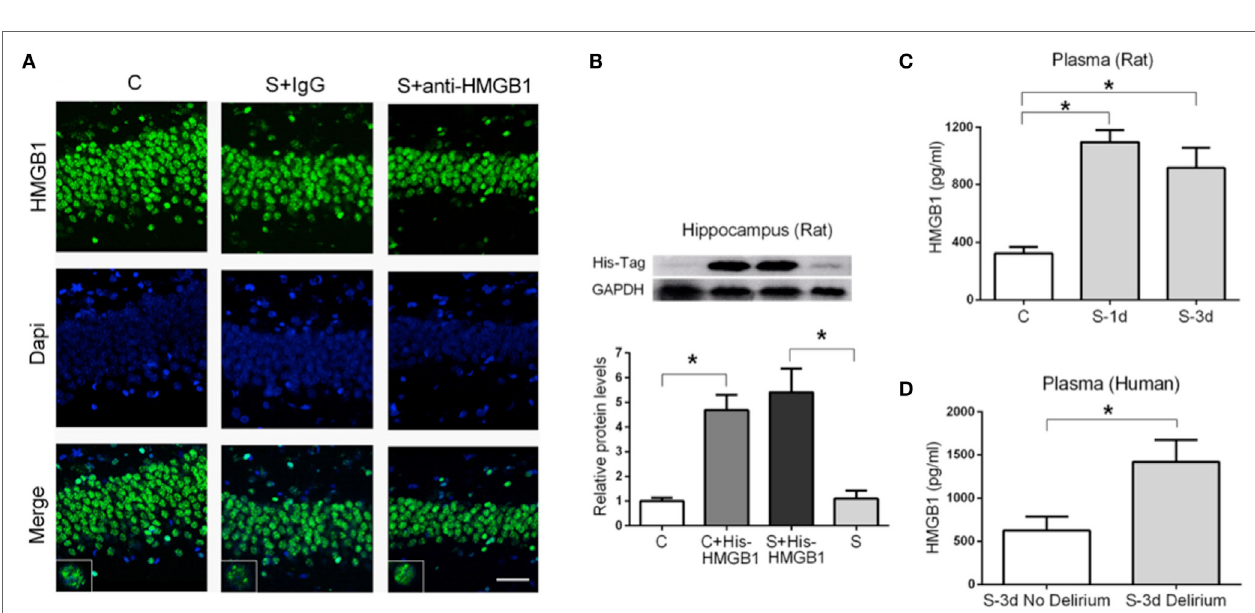
FigUre 4 | Microglia activation after surgery and effects of anti-hMgB1 . Neuroinflammation was assessed by Iba-1 immunofluorescence on postoperative day 3. Photomicrographs from DG and CA1 areas of the hippocampus are shown (a) . Surgery activated microglia as noted by morphological changes on day 3, including enlargement of cell bodies, which was attenuated by anti-HMGB1 mAb treatment. (B,c) show the quantification of Iba-1 immunofluorescence in DG and CA1, respectively. Results are expressed as mean ± SEM ( n = 5). * p < 0.05 by one-way ANOVA. Abbreviations: C, control; S, surgery. Scale bar = 50 μ m.